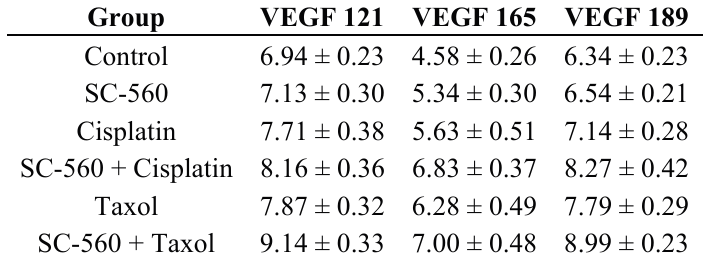
Table 1. Δ C t of VEGF in the six groups (control, SC-560, cisplatin, SC-560/cisplatin combination group, taxol and SC-560/taxol combination group) a